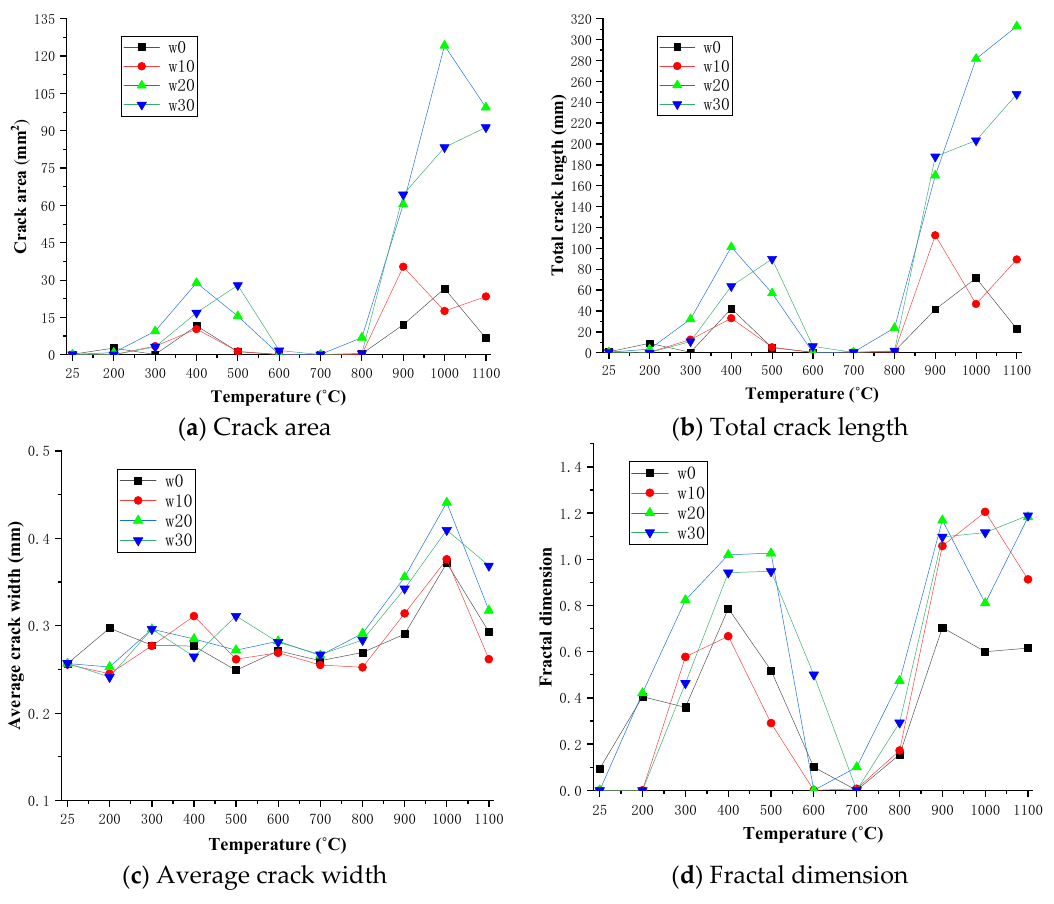
Figure 4. Surface crack parameters variation curves with temperature of the cube specimen (( a ): crack area curve; ( b ): total crack length curve; ( c ): average crack width curve; ( d ): fractal dimension curve).